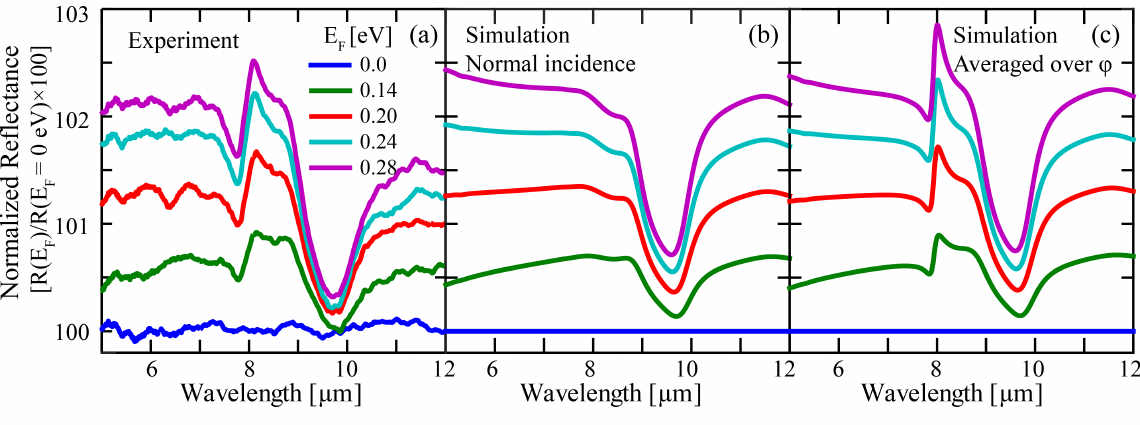
Figure 3: (a) Modulation of IR reflectivity of CVD graphene on Si/300 nm SiO 2 substrate as a function of sheet carrier density. Measurements wereperformedusingaFourierTransformInfrared(FTIR)Spectrometerwithmicroscopeaccessory(Objective:15X,N.A.0.58Reflectochromat); measurements are normalized to R CNP . (b-c) FEM simulations using a surface current model for graphene (COMSOL Multiphysics) at normal incidence and averaged over a range of angle of incidence ( φ ); the experimental data was fitted with carrier scattering time ( τ ) as a fitting parameter in the RPA model, which yields scattering time of 10